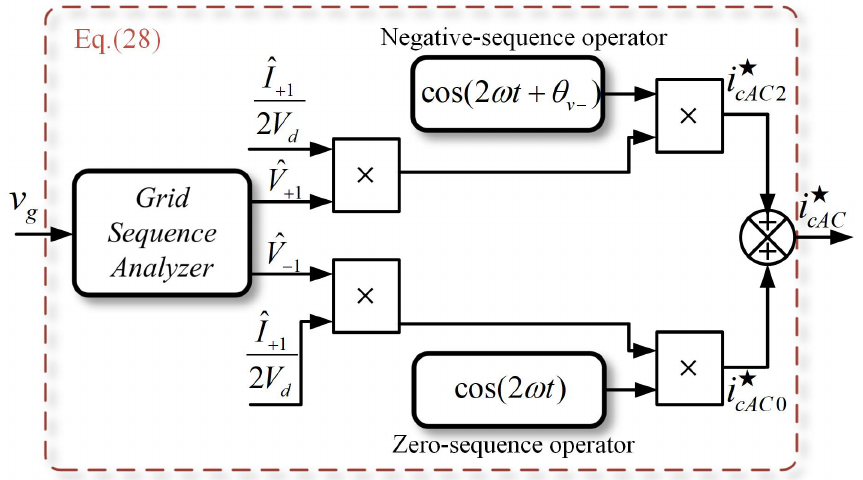
Figure 5. Block diagram of Method